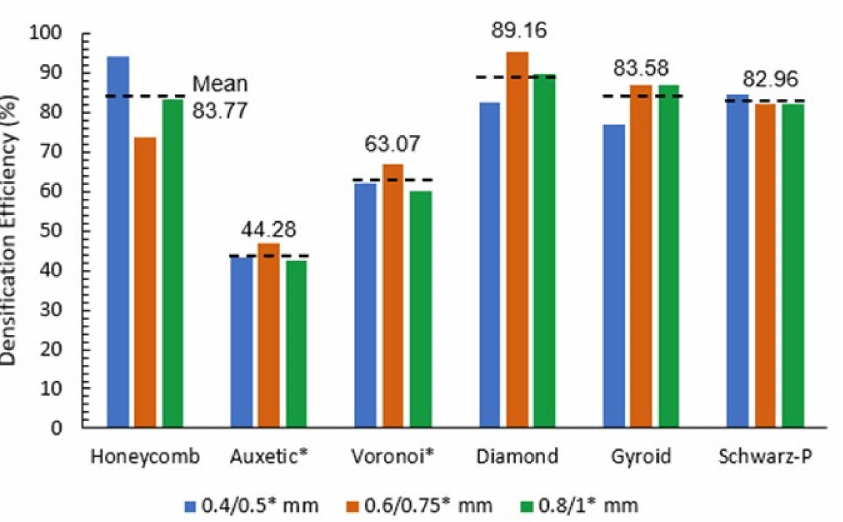
Figure 21. Comparison of densification efficiencies for each of the six shapes and three relative densities (dimensions marked with * correspond to lattice strut diameters used for auxetic and Voronoi structures, which were slightly larger than the wall thickness associated with the other